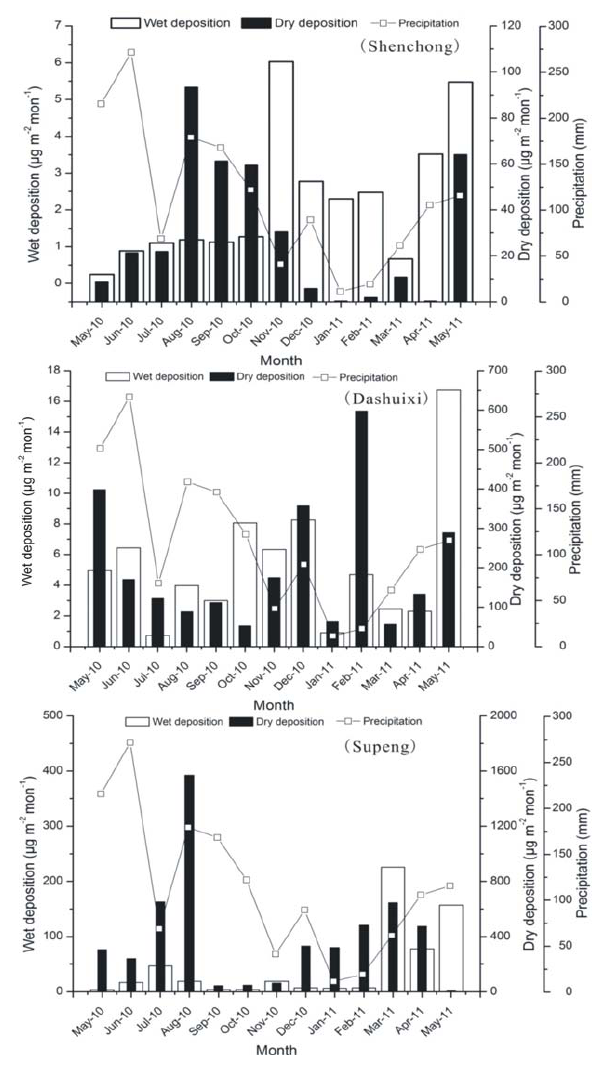
Fig. 5. Time series of monthly deposition fluxes and corresponding precipitation